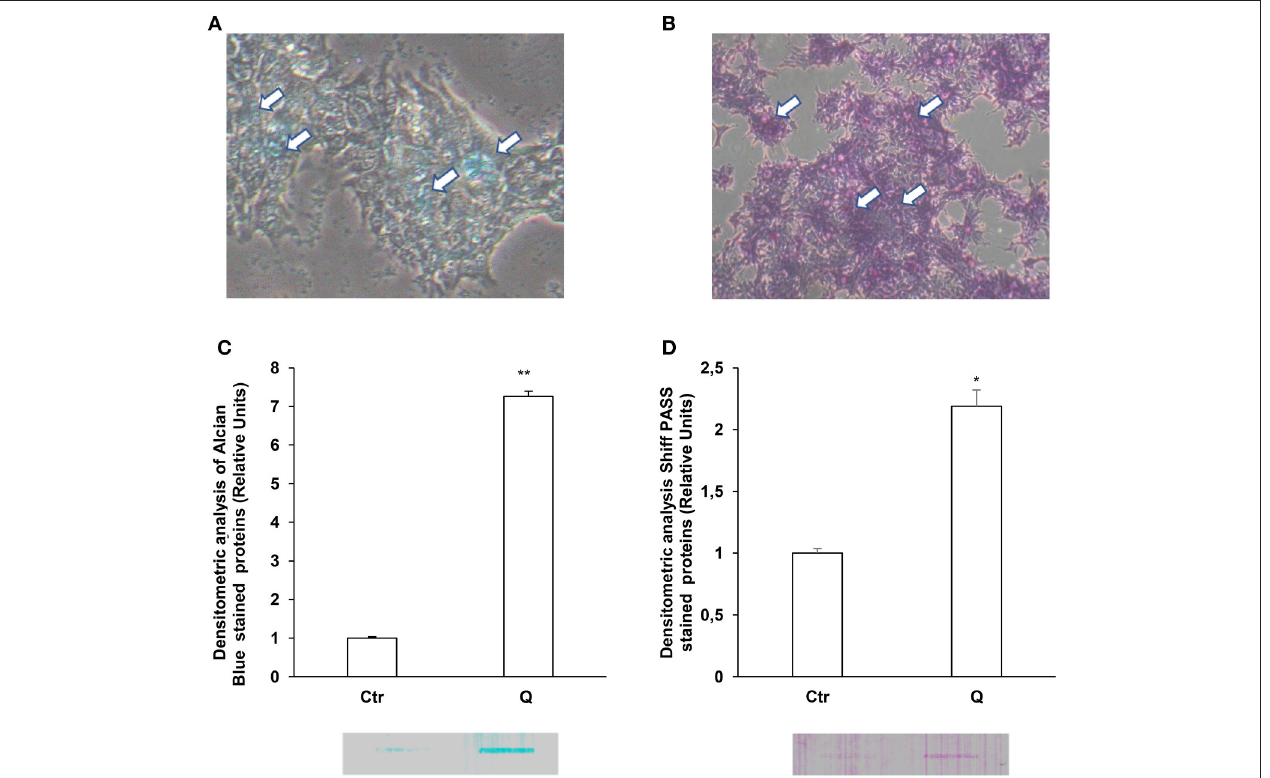
FIGURE 1 | Quercetin induces glycoprotein and glycosaminoglycan secretion in LS 174T. Periodic acid-Schiff (PAS) (A) and Alcian blue (B) staining of LS 174T cells. Arrows indicate intracellular mucous granules. (C,D) Slot Blot analysis of glycoproteins and GAGs in LS174T cell medium. Cells were incubated with MEM medium without FBS for 24h and stimulated with 50 µ M quercetin and membranes were stained with Periodic acid-Schiff (PAS) (C) and Alcian blue (D) . The histogram shows the mean ± SE ( n = 3) values of GAGs (C) and glycoproteins (D) levels obtained by densitometric analysis of protein bands and normalized to the respective intracellular protein concentrations of three independent experiments. * p < 0.05 vs. Ctr, ** p < 0.001 vs. Ctr.